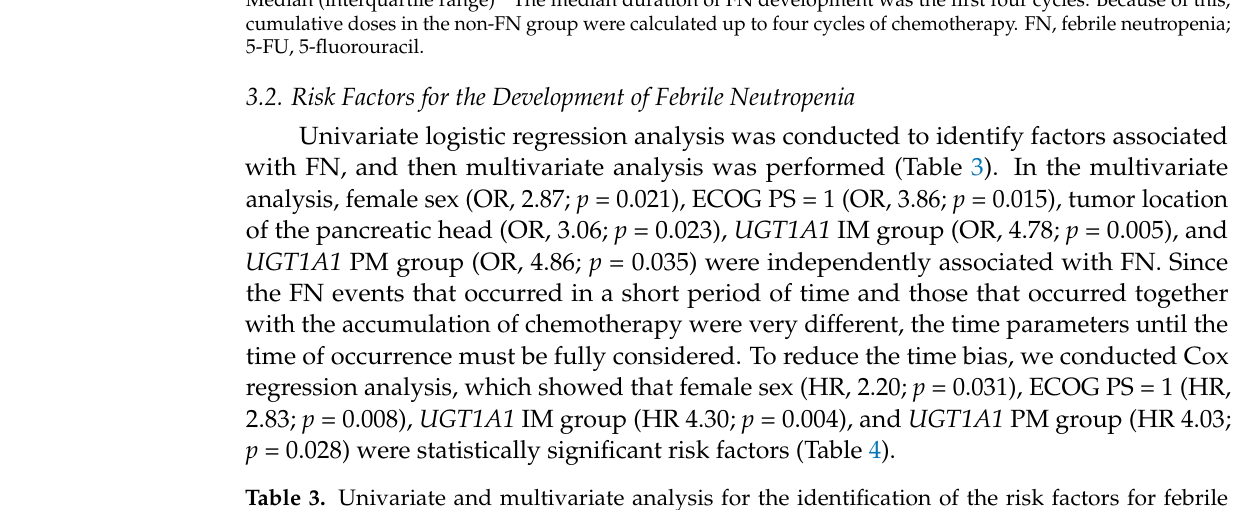
Table 3. Univariate and multivariate analysis for the identification of the risk factors for